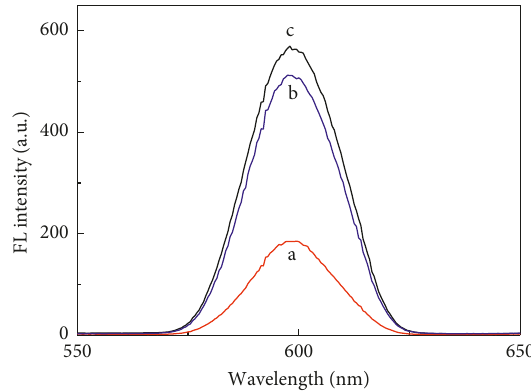
Figure 2: Fluorescence spectra of CdTe-QDs@MIPs before (a) and after (b) removal of FA and fluorescence spectra of CdTe-QDs@ NIPs (c).